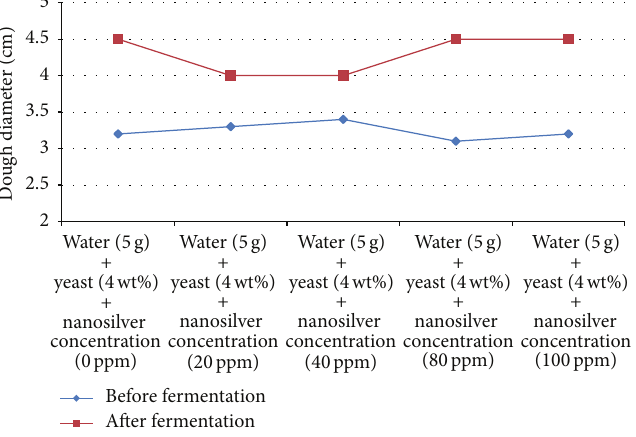
Figure 8: Experimental result of antibioactive effect of